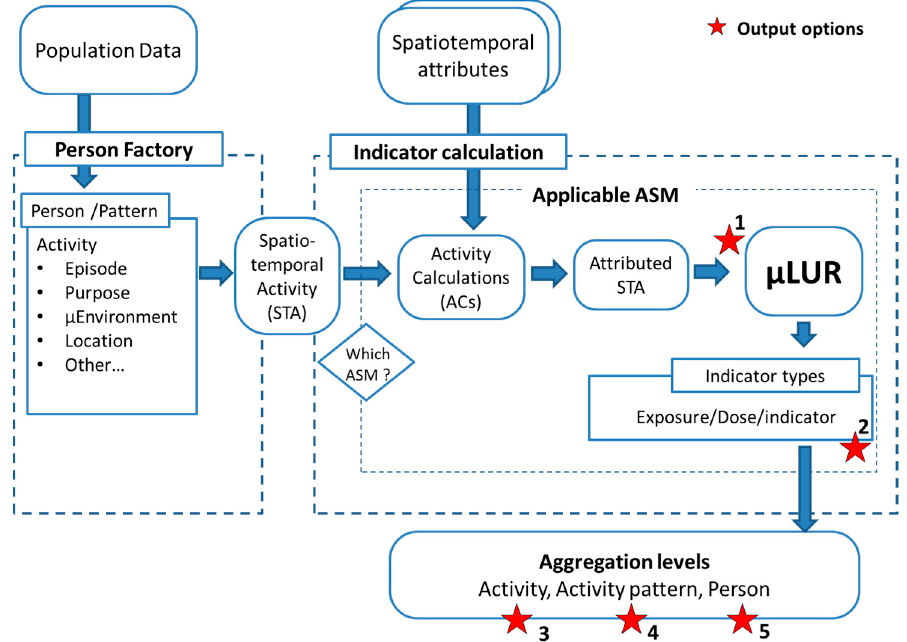
Figure 3. The person factory creates the person, time-activity pattern, and activity objects from the external population data. The first action in the “Indicator Calculation” is to dispatch the activity to the applicable activity specific model (ASM). The Spatiotemporal Activity assembles all personal data and triggers the indicator calculation. The applicable ASM contains a sequence of Activity Calculations retrieving the external data and performs every relevant action on the data (external and activity data). This results in an attributed Spatiotemporal Activity. The µLUR is applied and results in the indicator. The five stars identify the stages in the process where data can be retrieved and reporting is initiated.